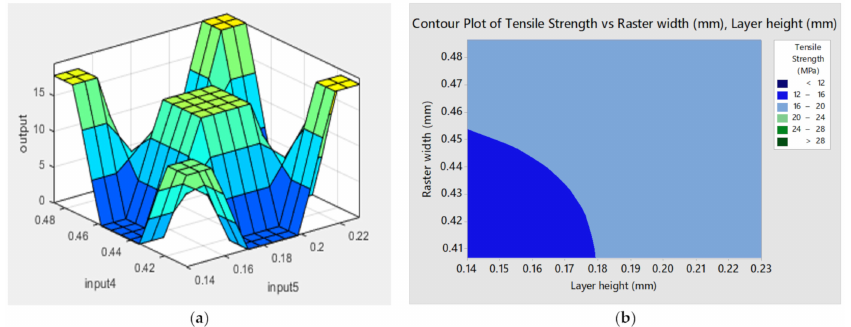
Figure 8. 3D plot ( a ) and contour plot ( b ) of tensile strength vs. raster width and layer